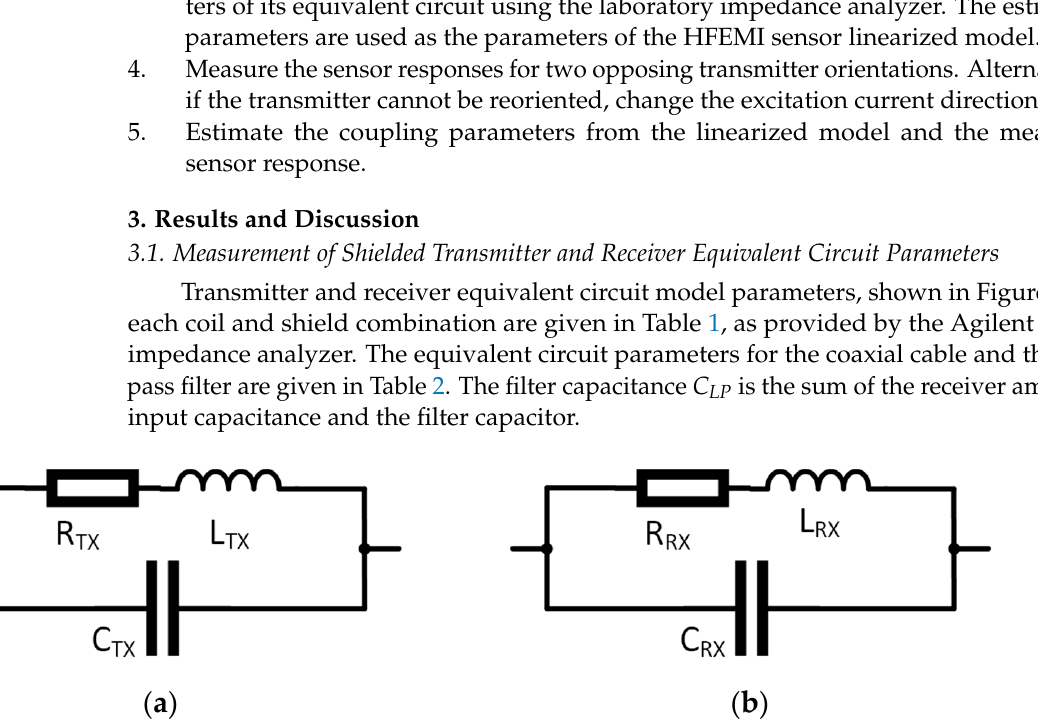
Table 1. Transmitter and receiver equivalent circuit parameters.